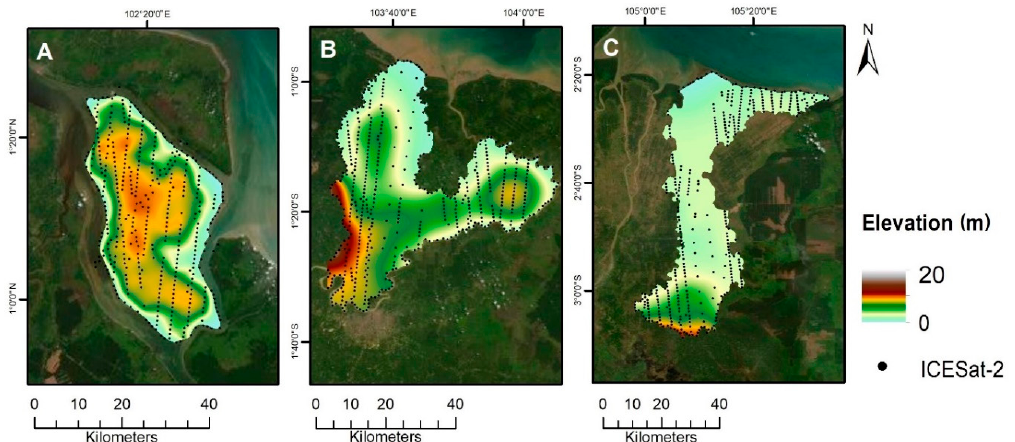
Figure 7. Peat surface modeling results for three large PHU in Sumatra. Pulau Padang (A), Sungai Mendahara–Sungai Betanghari (B) and Sungai Saleh–Sungai Sugihan (C). ICESat-2 footprints used for the interpolation are shown as black circles. Table 3. Comparison of the elevation based on airborne data and ordinary kriging (OK) results for the different PHUs located on Sumatra (N points = 500 per PHU). PHU